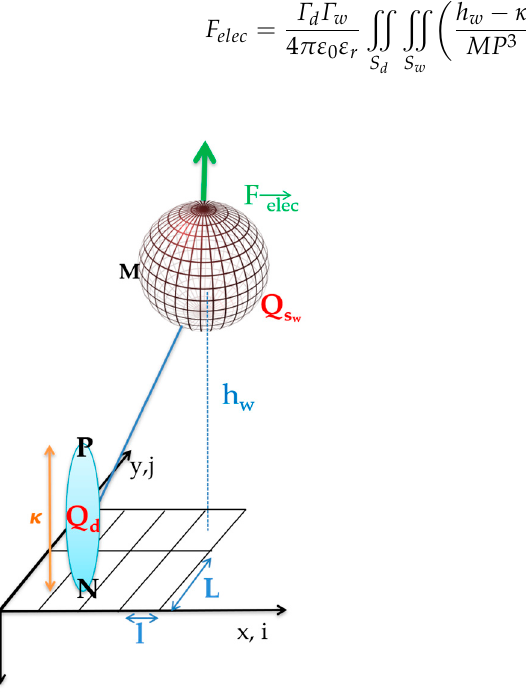
Figure 2. Geometric modeling between charged micro-object and surface. The relative scale was not respected: distance κ was weaker than the diameter of the sphere. QSw and Qd the charge of the sphere and of the dipole respectively, κ the length of the dipole.